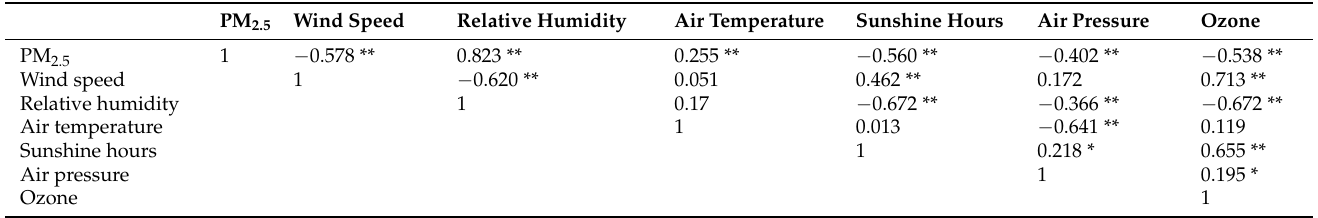
Table 1. Spearman correlation among daily means of PM 2.5 , ozone, and meteorological parameters in